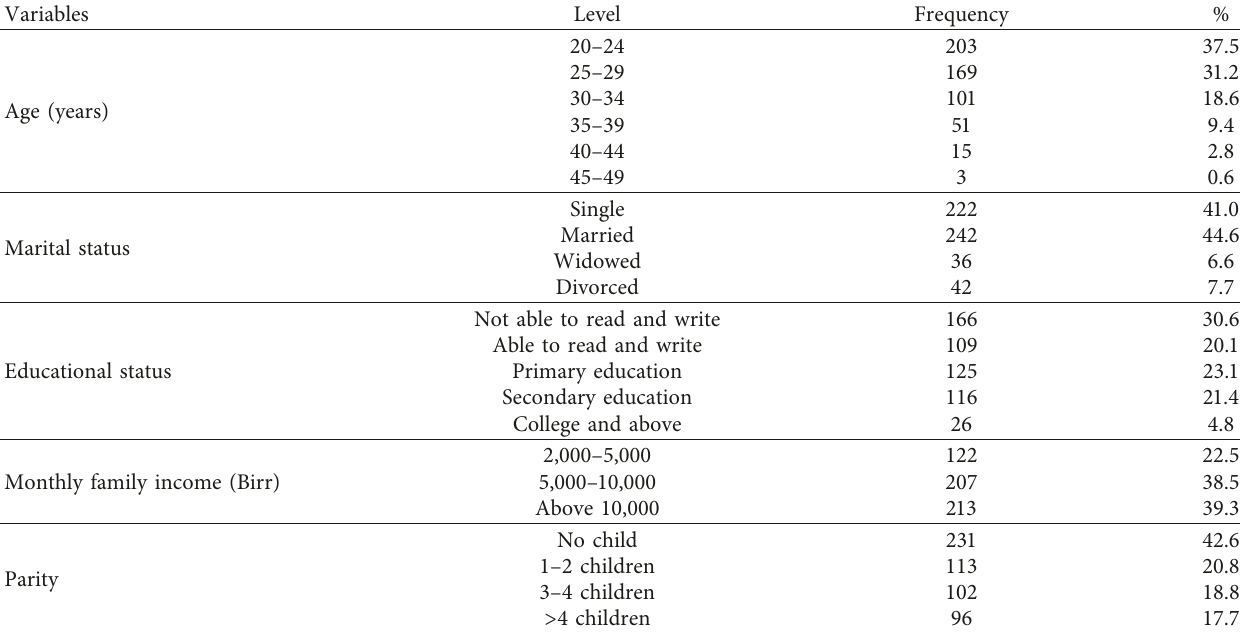
Table 1: Sociodemographic characteristics among women of reproductive age in Dire Dawa, 2021 ( n � 542). Variables